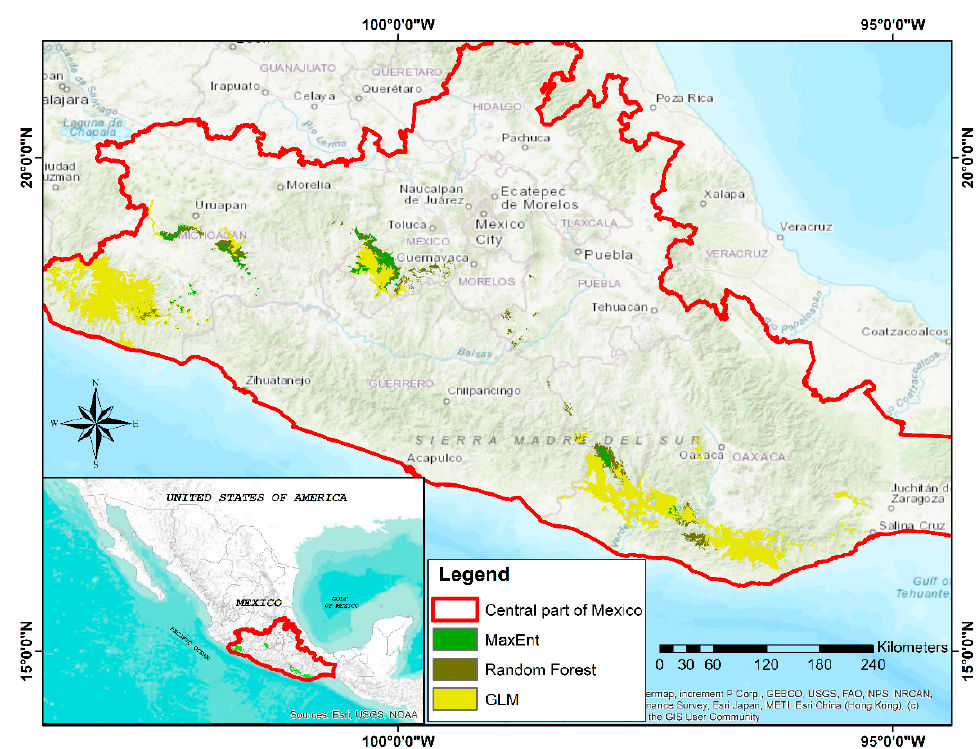
Figure 10. Spatial distribution of suitable areas for developing plus trees of Pinus oocarpa .